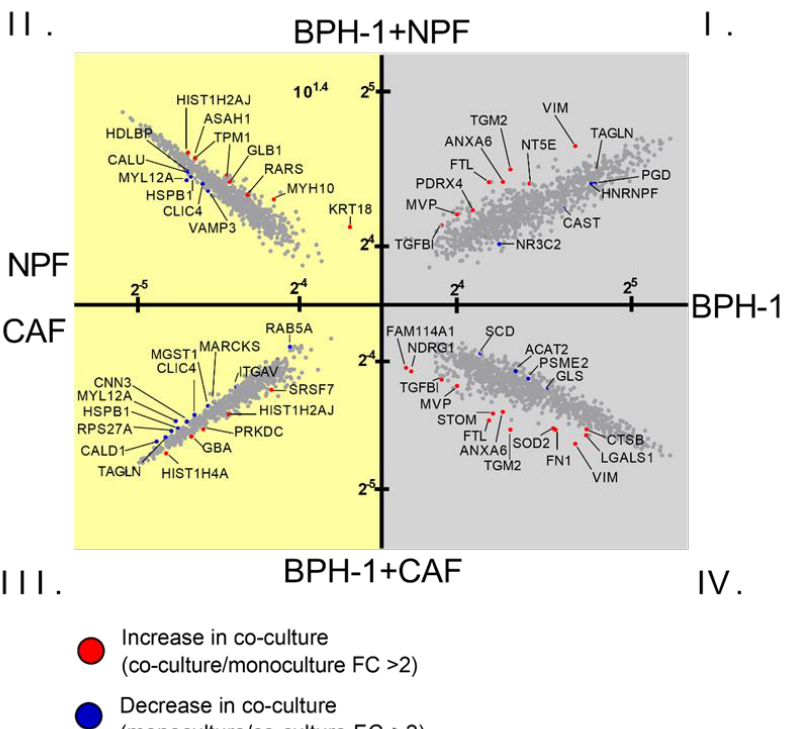
Figure 2. X-plot of differentially abundant proteins in BPH-1/fibroblast co-culture compared to monoculture. Scatter plots representing mean log2-transformed protein abundance; x -axis represents abundance in monoculture, and y -axis represents abundance in co-culture. Proteins significantly upregulated (red dots; protein level in co-culture/corresponding monoculture) and downregulated proteins (blue dots; protein level in monoculture/corresponding co-culture) in co-culture were selected using a cut-off value of FC > 2. Proteins closer to the y -axis represent an increase of expression, while proteins closer to the x -axis represent a decrease of expression upon co-culture. Grey background: BPH-1 protein expression, yellow background: fibroblast protein expression. FC: fold change. Quadrant I: BPH-1 proteins in monoculture compared to BPH-1 proteins in co-culture with NPFs, Quadrant II: NPF proteins in monoculture compared to NPF proteins in co-culture with BPH-1 cells, Quadrant III: CAF proteins in monoculture compared to CAF proteins in co-culture with BPH-1 cells, Quadrant IV: BPH-1 proteins in monoculture compared to BPH-1 proteins in co-culture with CAFs. Data represent mean protein abundance across 3 biological replicates with NPFs and CAFs from a single patient.